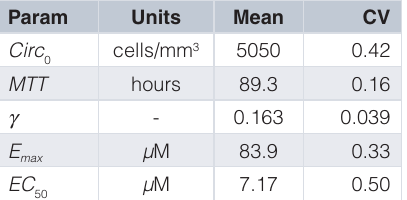
: baseline 0 , E : 50 max max